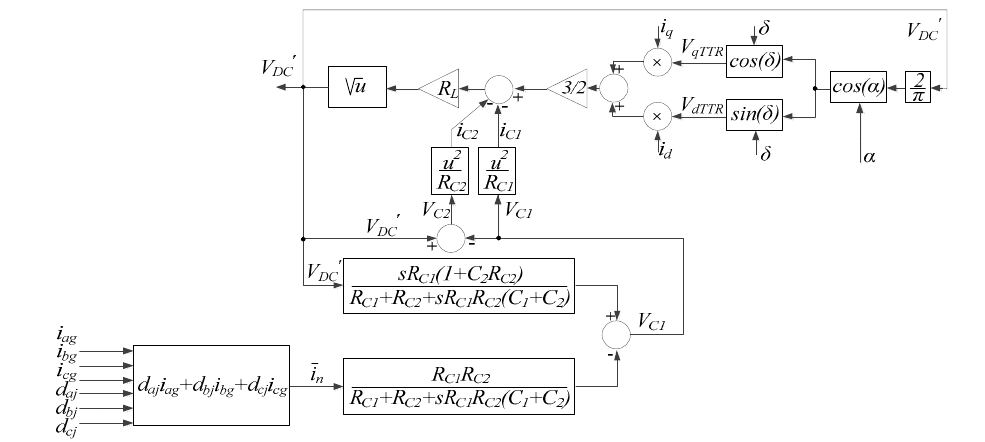
Figure 6: Block diagram of the Vienna rectifier model. Figure 6. Block diagram of the Vienna rectifier